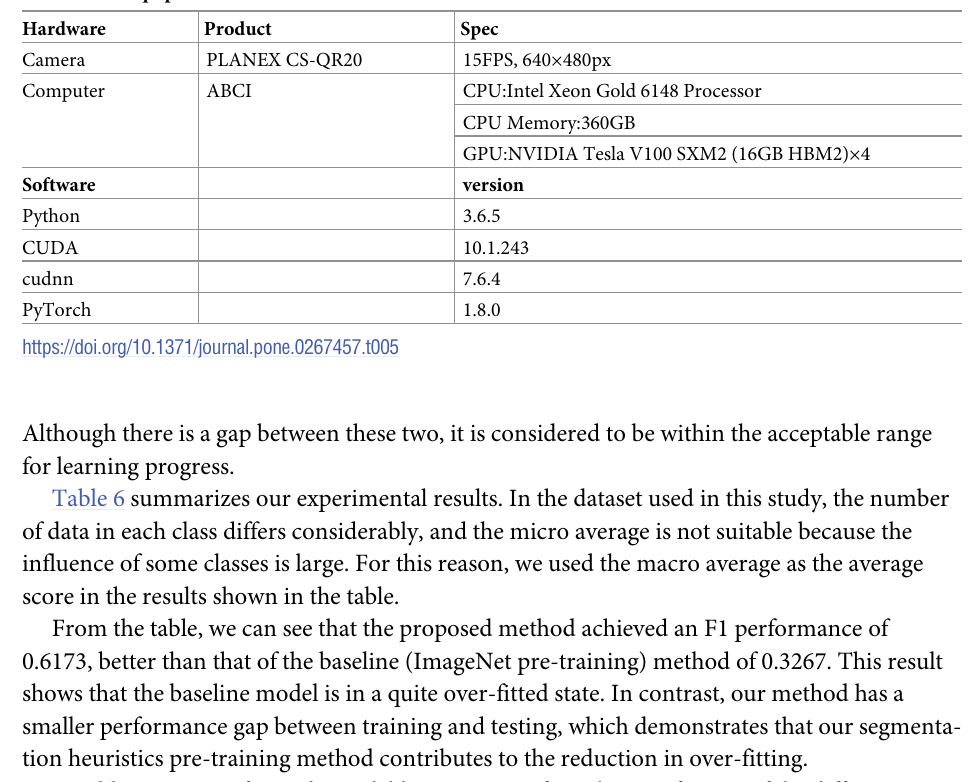
Table 5. The equipment hardware and software infrastructure details.